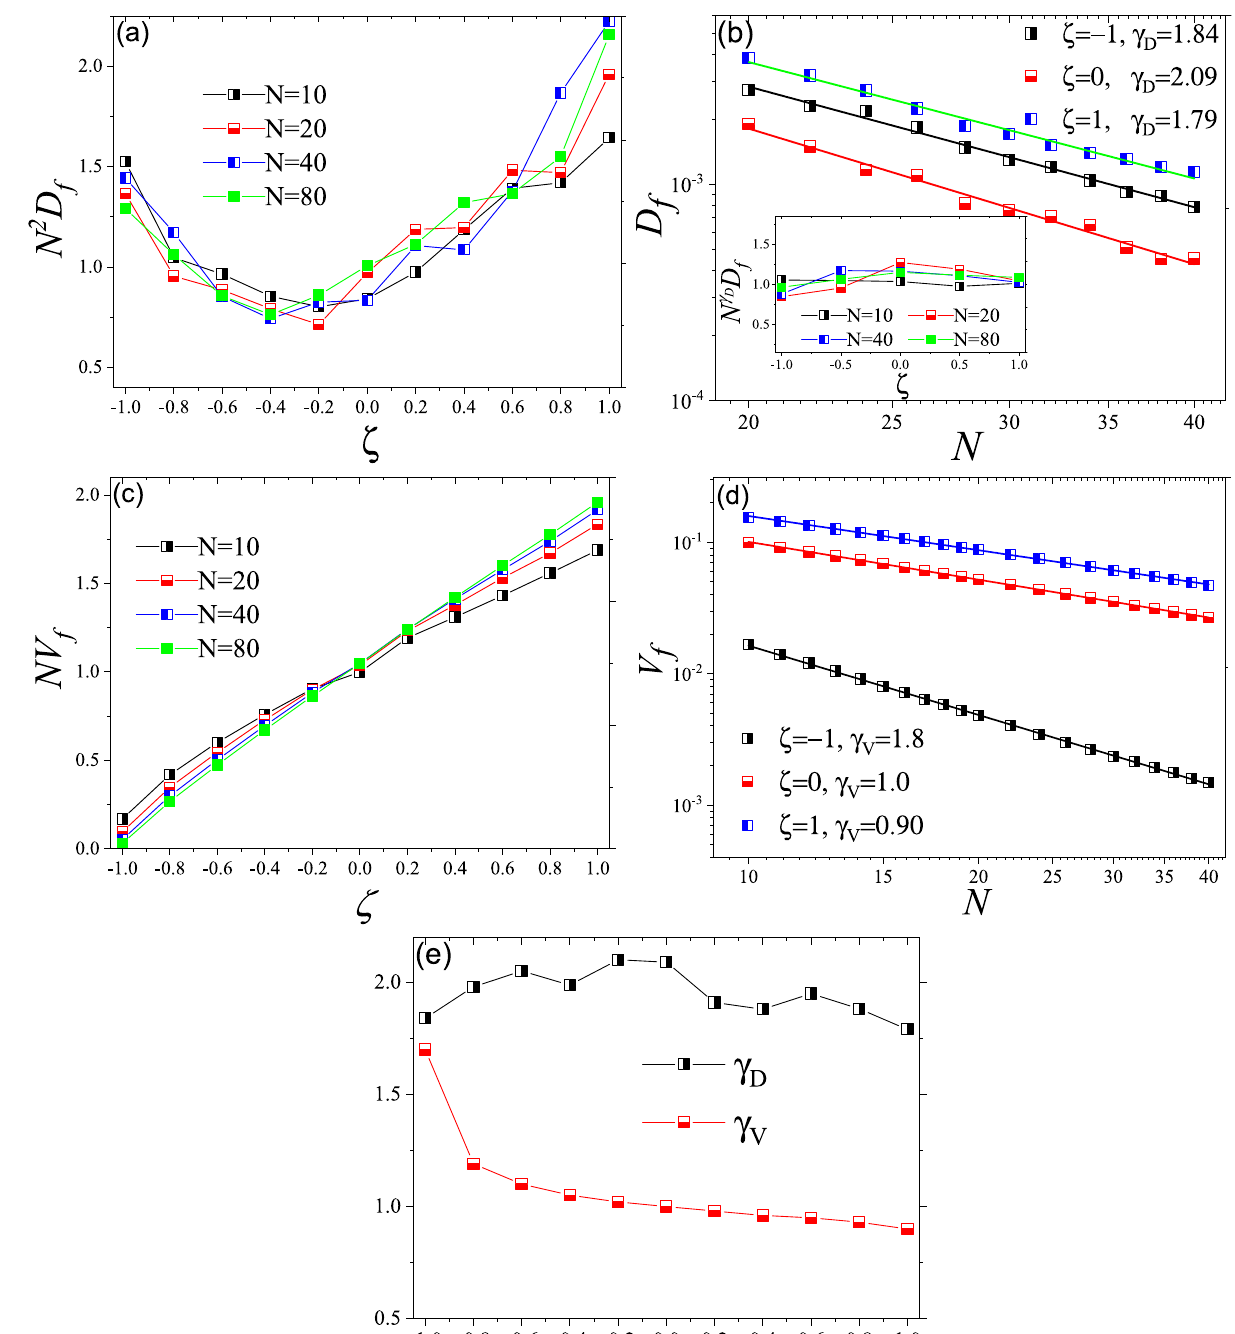
2 D f for different values of 0 ∼